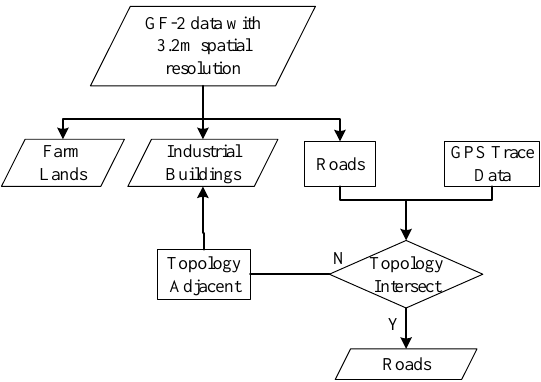
merge Figure 7. Flowchart for extracting vegetation and barren lands. 2.5.4. Farm Lands, Roads and Squares, and Buildings For this research, GF-1 images were collected in summer, while GF-2 images were acquired in late spring. During the late spring, many farm lands only contain bare soil with scattered crops, while trees, shrubs, and grass are with green leaves. Therefore, it is feasible to distinguish farmlands from vegetation (e.g., trees, shrubs, and grass) using GF-2 data. Because most farm lands are with